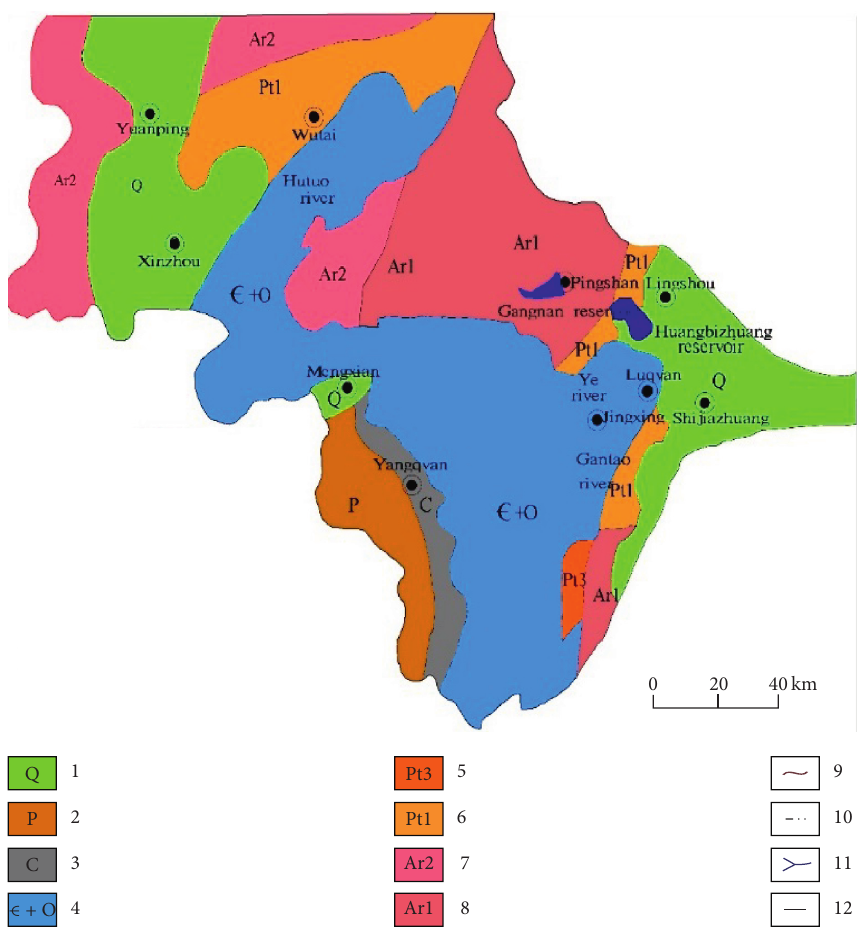
Figure 9: A geological sketch of the upstream region of the Hutuo River: (1) Quaternary system; (2) Permian system; (3) the carboniferous; (4) Cambrian Ordovician; (5) upper Paleozoic erathem; (6) lower Paleozoic erathem; (7) the Wutai group of the archaic kingdom; (8) Fuping group of the ancient kingdom; (9) basin boundary; (10) provincial boundary; (11) the rivers; and (12) stratigraphic boundary.